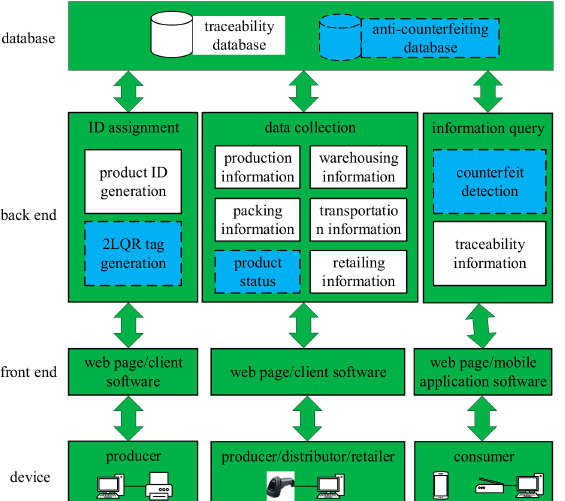
Figure 3. The anti-counterfeiting architecture for traceability system based on 2LQR codes. The white solid boxes are submodules of a basic traceability system. The blue dashed boxes are submodules for